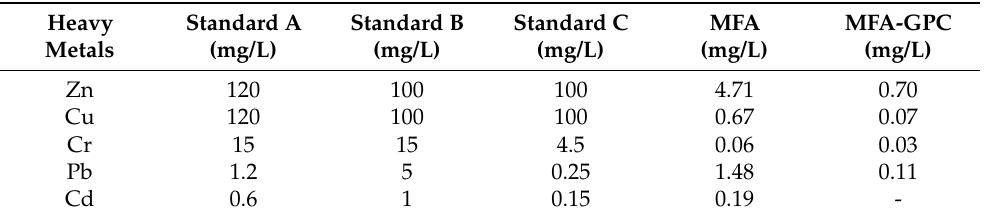
Table 4. Results of heavy metal leaching of MFA and